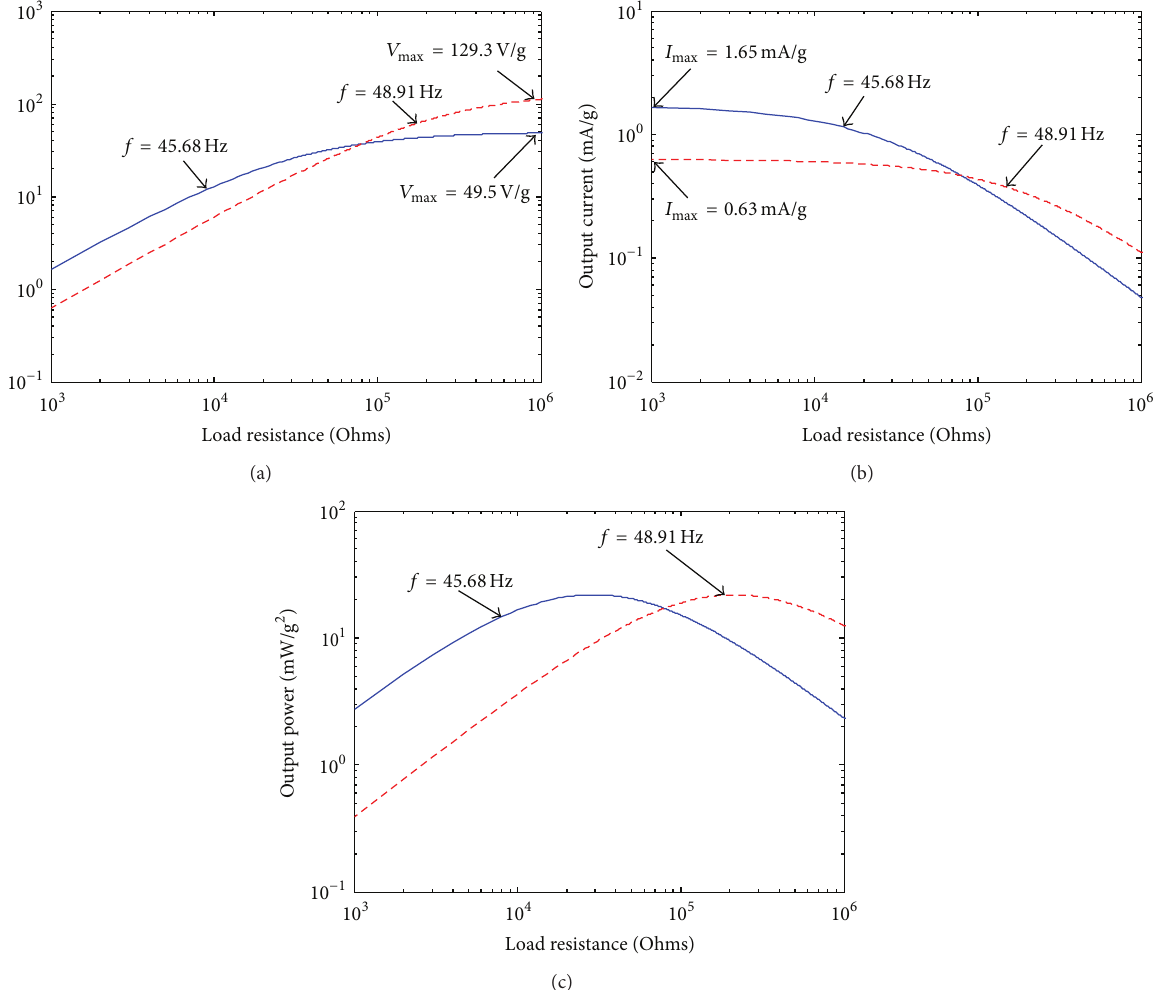
Figure 10: Variations in output voltage, output current, and output power of PVEH with load resistance at the resonance and antiresonance frequencies: (a) voltage, (b) current, and (c) power.